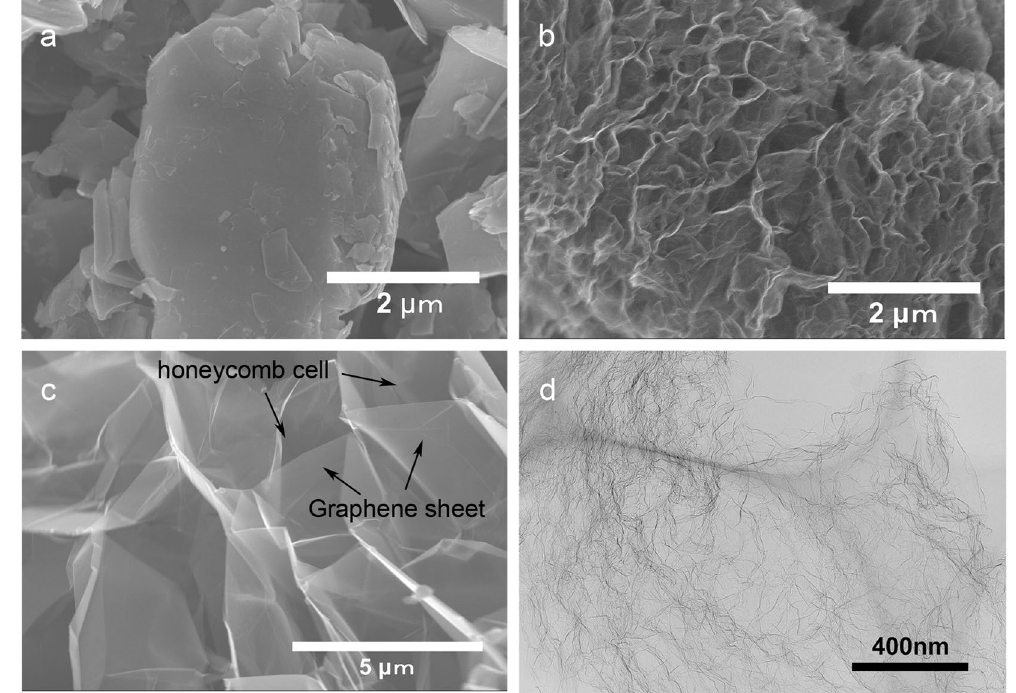
Figure 2. SEM images of ( a ) graphite raw materials for MG, ( b ) PreMG, and ( c ) MG and ( d ) TEM image of MG.